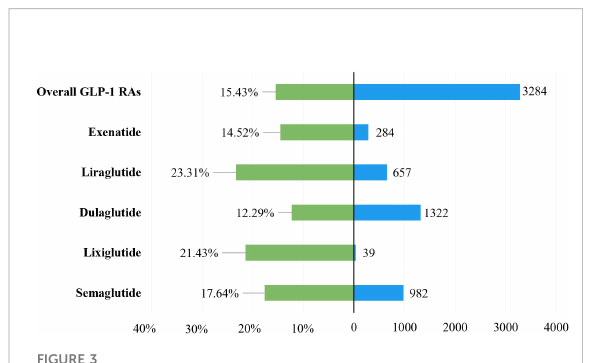
FIGURE 3 The case severe rate for GLP-1 RA-related gastrointestinal